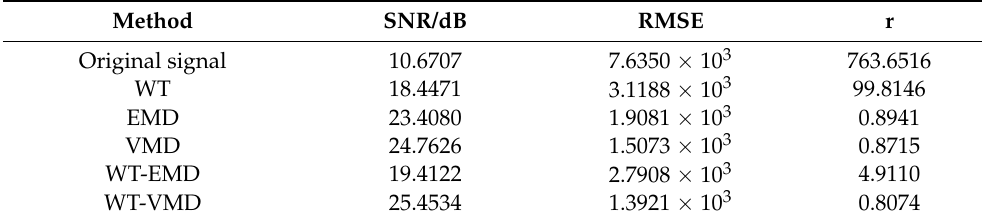
Table 1. Evaluation Index of 50-pulse cumulative signal (no pollution) after